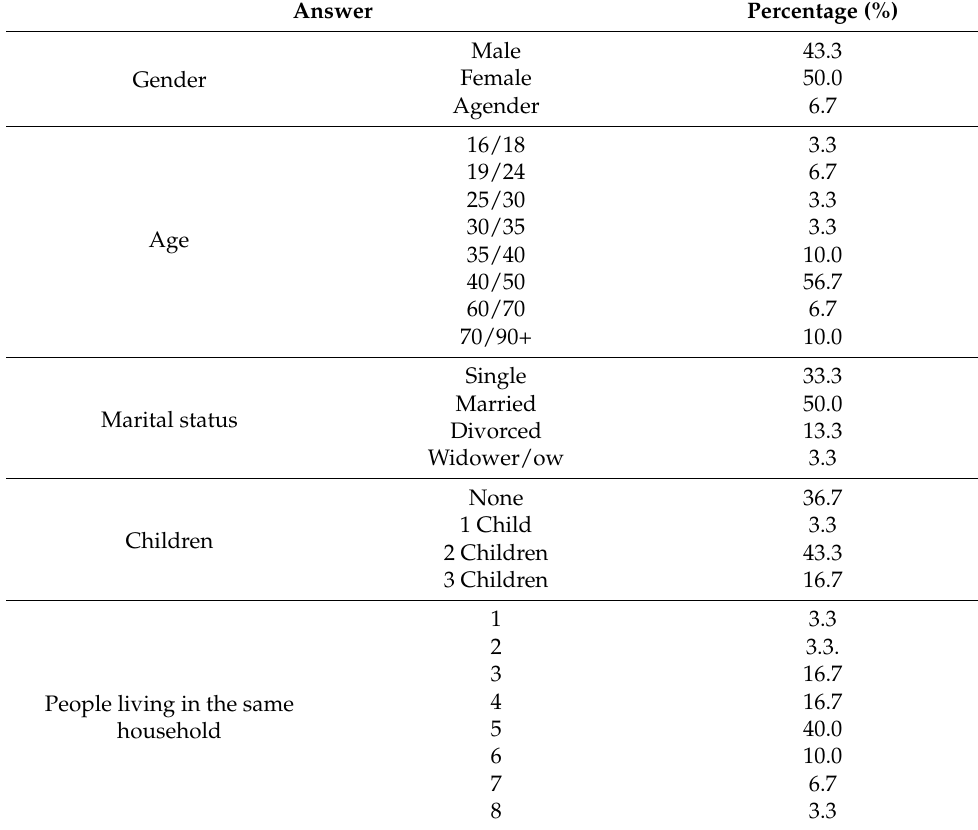
Table 2. First set of responses from the preliminary investigation.